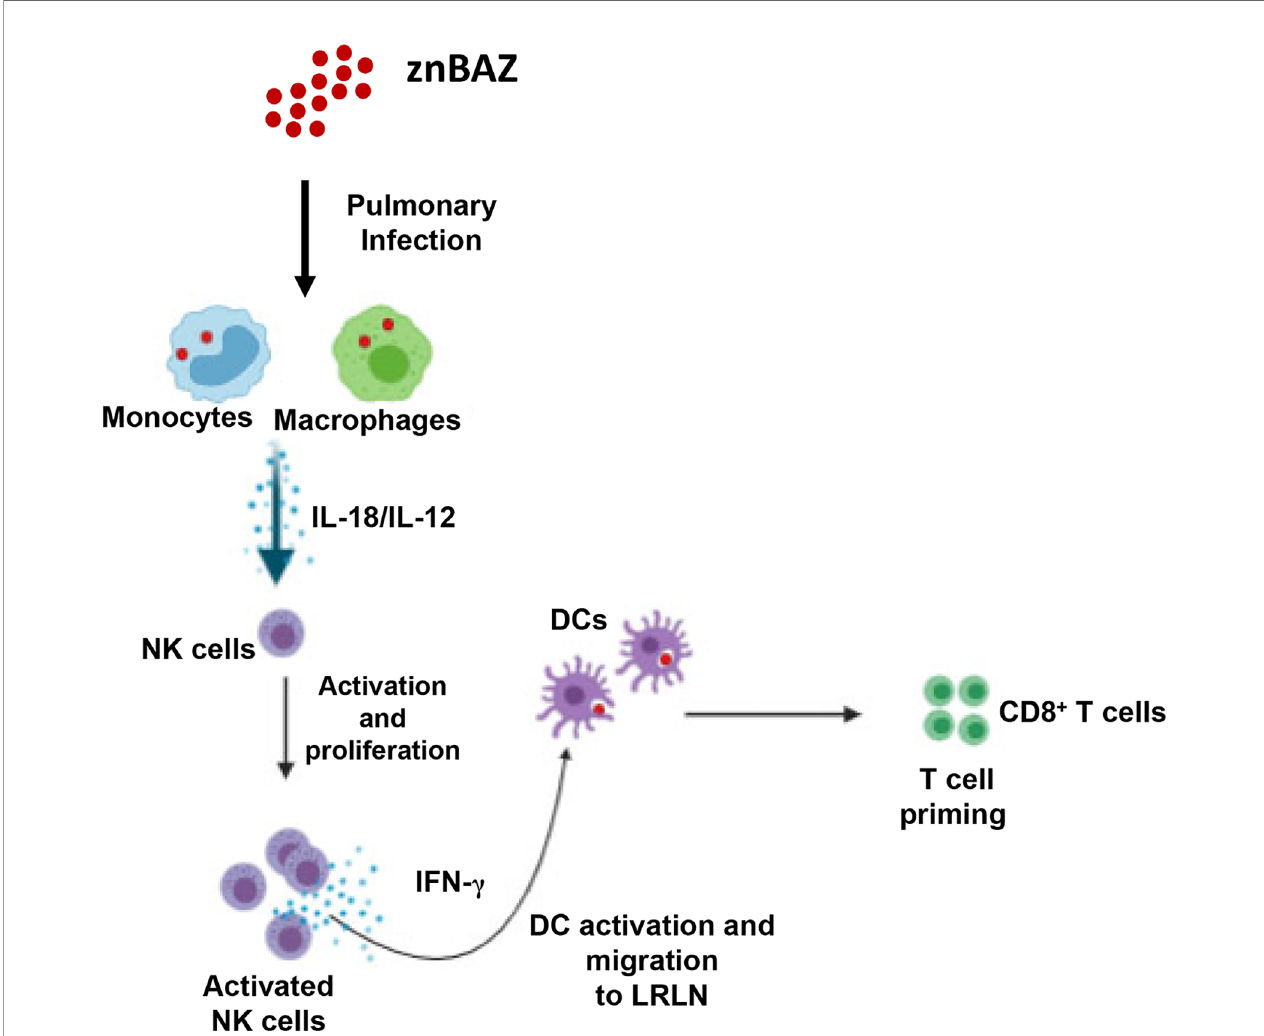
FIGURE 7 | A schematic representation * highlighting the role NK cells in znBAZ-induced CD8 + T cell response. znBAZ is phagocytosed by lung in fl ammatory monocytes and monocyte-derived macrophages, which upon activation releases IL-12 and IL-18. These cytokines induce early NK cell activation. Early activation of lung NK cells releases granzyme B and IFN- g . Granzyme B induces death (apoptosis/necrosis or both) of infected cells, and IFN- g induces lung DC activation. These activated lung DCs uptake the bacterial Ags or engulf znBAZ or indirectly by phagocytizing infected host cells. After Ag uptake, DCs then migrate to lower respiratory lymph nodes (LRLNs), where they prime naïve T cells. These DC-primed CD8 + T cells becomes activated, undergo differentiation, and migrate to the site of infection (lungs) to provide protection. (Depiction was used generated using a program from